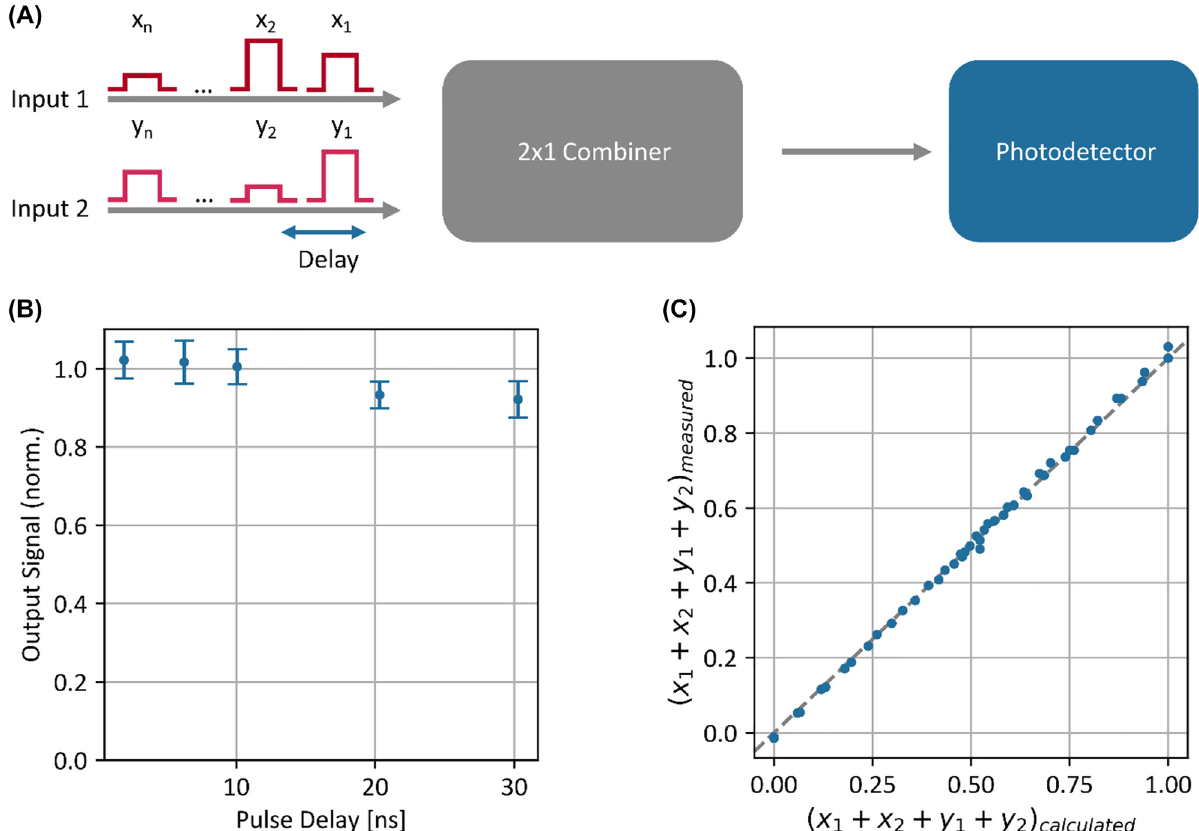
Figure 2: Time multiplexed incoherent accumulation. (A) Concept of time multiplexed incoherent accumulation. We combine two accumulation schemes, temporally overlapping pulses of different wavelength and charge accumulation inside a detector by delayed pulses. Both processes are phase insensitive. (B) Accumulation time of a 10 MHz Photodetector. We determine the accumulation time of the photodetector by comparing the detector signal of the delayed accumulated pulse with the signal of the individual pulses. Up to a delay of about 10 ns the error induced by this accumulation scheme is within the uncertainty of the measurement setup. (C) Accuracy of time multiplexed incoherent accumulation. We accumulate four different 1 ns pulses as sketched in (A) with a delay of 1.86 ns. The measured signal is distributed around the calculated signal with a standard deviation of 1.1% which is comparable the noise within the measurement setup